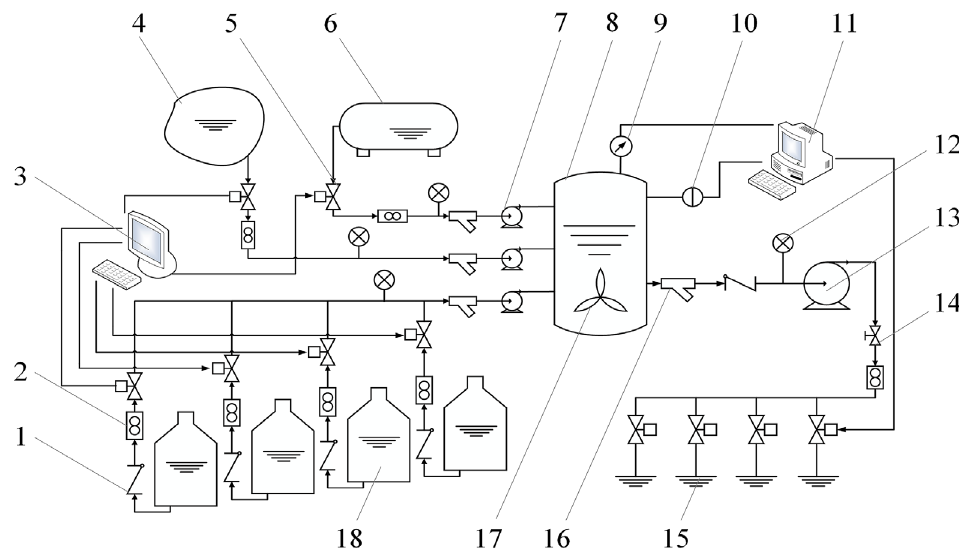
Figure 1. Water and fertilizer integration and control equipment structure diagram: 1—check